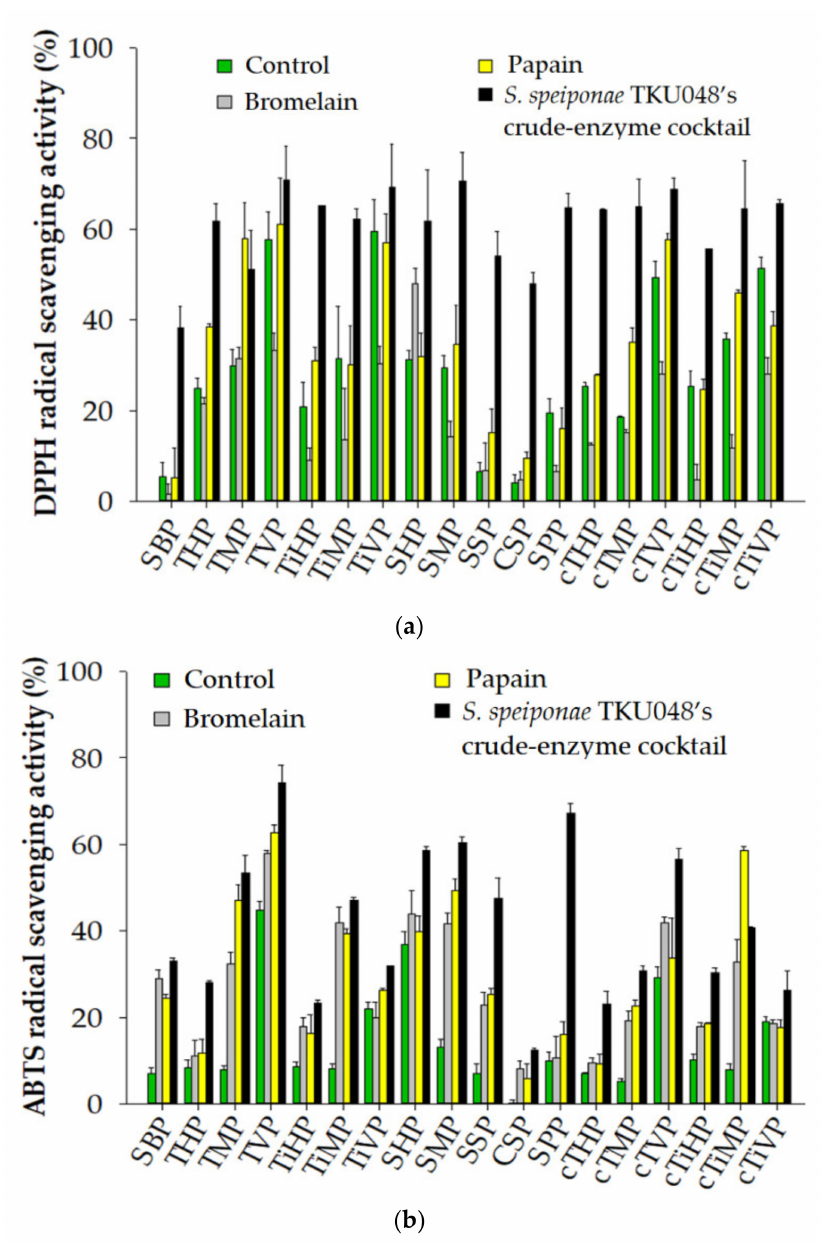
Figure 6. DPPH ( a ) and ABTS ( b ) radical scavenging activity of the hydrolysates produced by papain, bromelain, and S. speibonae TKU048 (cid:48) s crude-enzyme cocktail. All data points are means ± S.D. of three different experiments (each experiment was conducted in